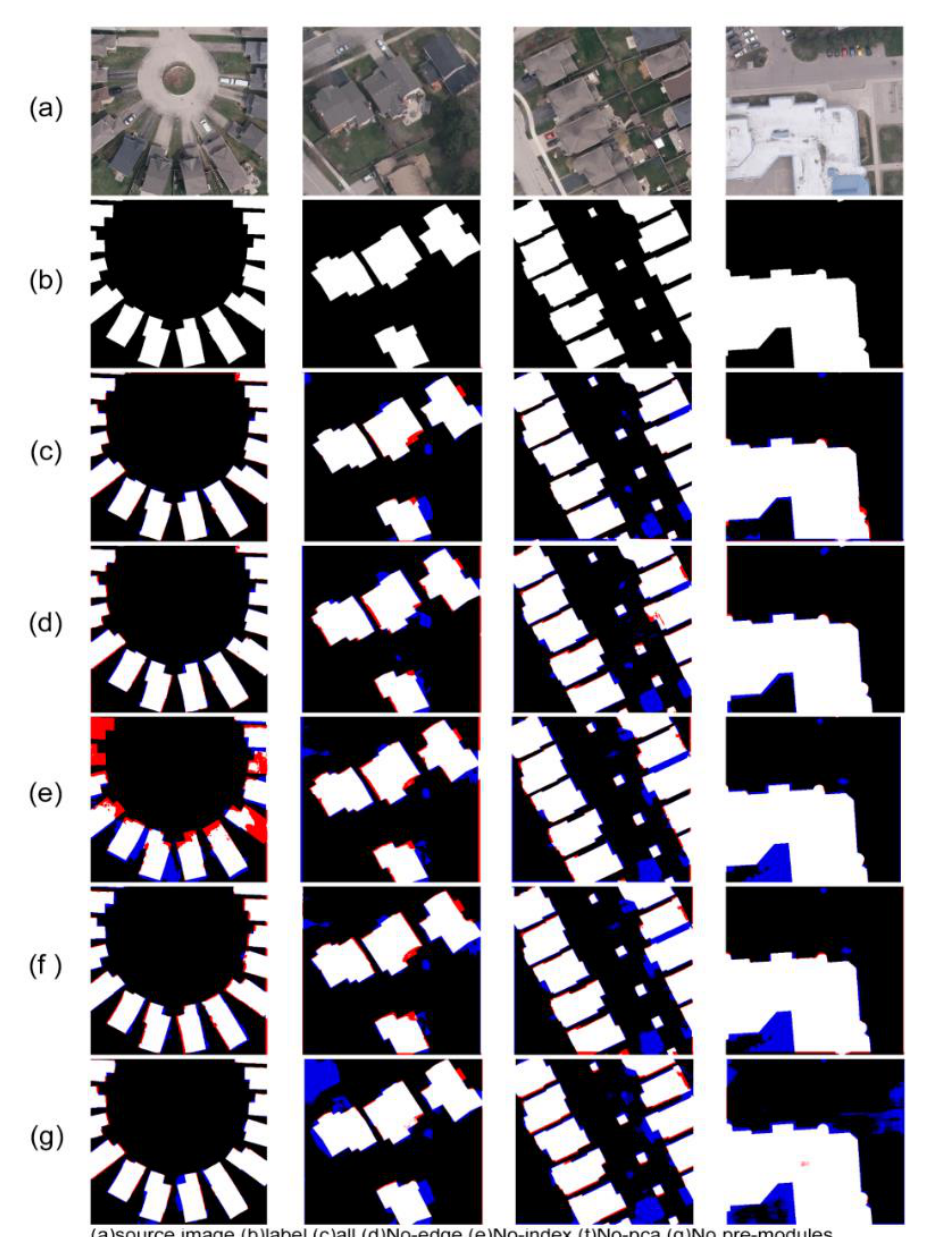
Figure 7 . Examples of ablation study